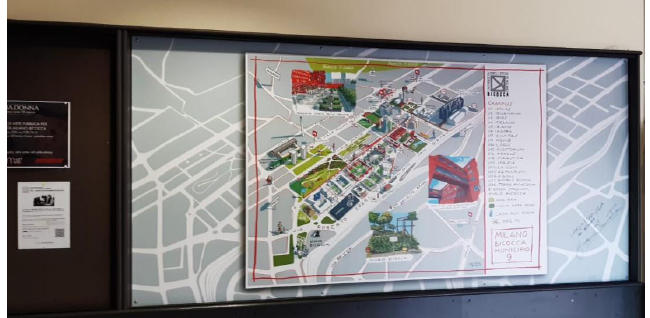
Figure 6 Carlo Stanga work in Agorà-U6